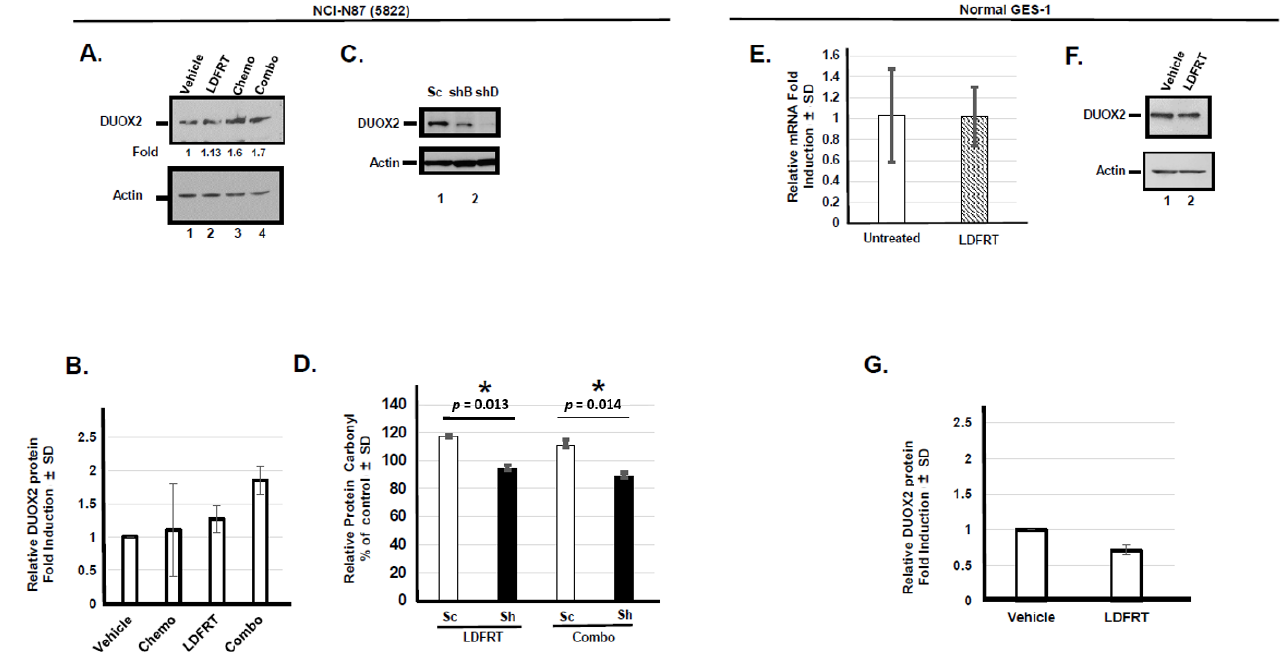
Figure 1. DUOX2 expression and activity in human gastric cells. ( A ) Western blots analysis of gastric cancer NCI-N87 (5822) cells exposed to the indicated treatment. ( B ) Quantitation of the Western blots. Fold induction was measured by densitometry and normalized to Actin and the untreated sample (Vehicle). ( C ) Down-regulation of DUOX2 in NCI-N87 cells, shD cells were used for all other shDUOX2 experiments. ( D ) Relative protein carbonyl content in the media of NCI-N87 cells expressing endogenous (Sc: Scrambled) or reduced (Sh) DUOX2 levels expressed as a percentage of the respective untreated samples, set at 100%, in the indicated cells exposed to LDFRT or the combined regimen of mDCF and LDFRT. * p values, Student’s t test. p < 0.05 is considered significant. ( E ) DUOX2 mRNA expression in normal gastric epithelial GES-1 cells untreated or exposed to radiation (LDFRT). n = 3. ( F ) Western blots of DUOX2 in GES-1 cells exposed to the indicated treatment. ( G ) Quantitation by densitometry of the GES-1 Western blots. n = 3.